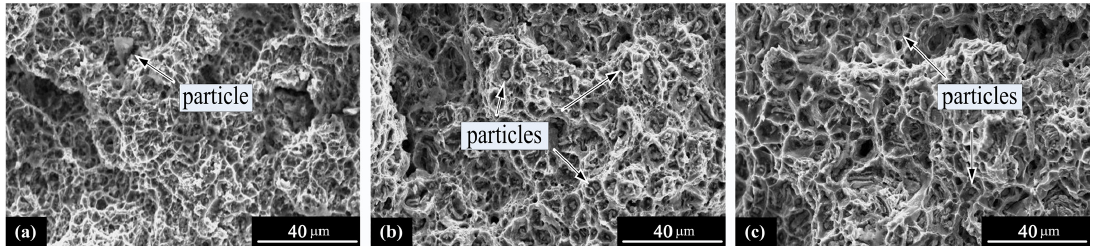
Figure 6. Tensile fracture surfaces of as-extruded (a) Gd-containing, (b) Nd-containing and (c) Ce-containing alloys.